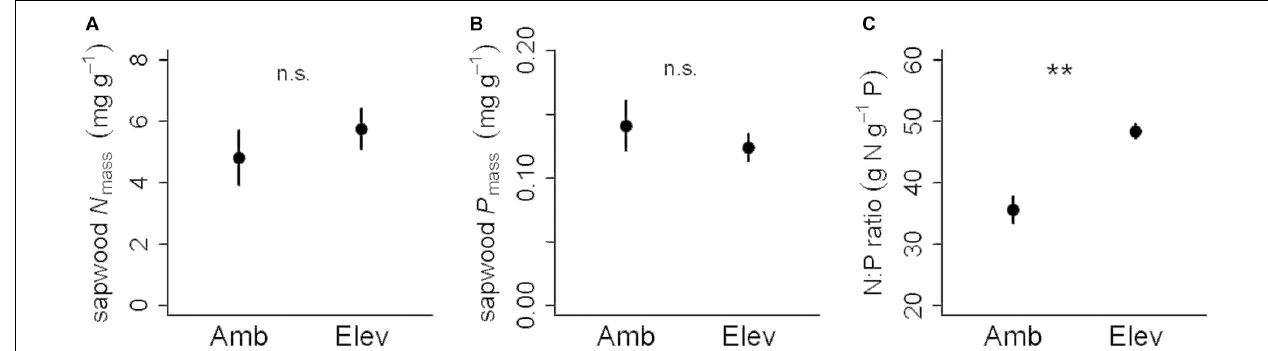
FIGURE 5 | Means and standard errors for chemical composition of sapwood in ambient (Amb) and elevated (Elev) CO 2 treatments for (A) mass-based nitrogen concentration in mg g − 1 , (B) mass-based P concentration in mg g − 1 and (C) N:P ratio. While N and P concentrations did not differ between CO 2 treatments (n.s. in panels A and B ), the N:P ratio in wood was significantly increased in elevated CO 2 compared to ambient CO 2 at P < 0.01 ( ∗∗ in panel C ).